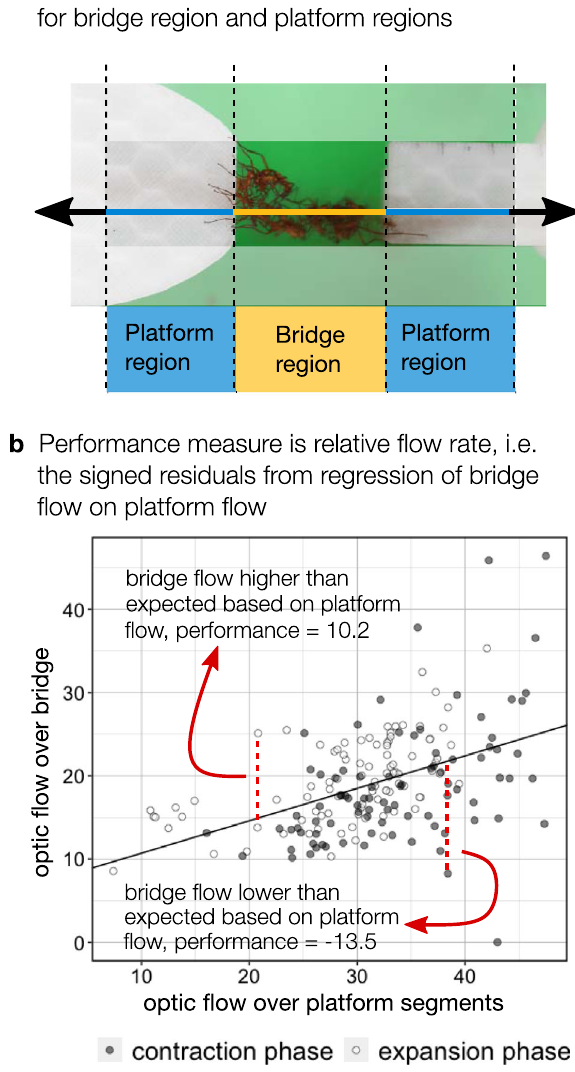
Fig. 5 Measuring bridge performance. a We used optical fl ow to measure the fl ow rate of ants across the platforms and bridge. b Our measure of performance was the fl ow rate of ants over the bridge relative to what would be expected based on the fl ow rate over the nearby platforms, i.e., the signed residuals from separate regressions for each trial of bridge fl ow on platform fl ow. Optical fl ow measures the amount of movement from one video frame to the next, in units of pixels per frame. Additional details of optical fl ow data extraction and the performance metric are included in Supplementary Note